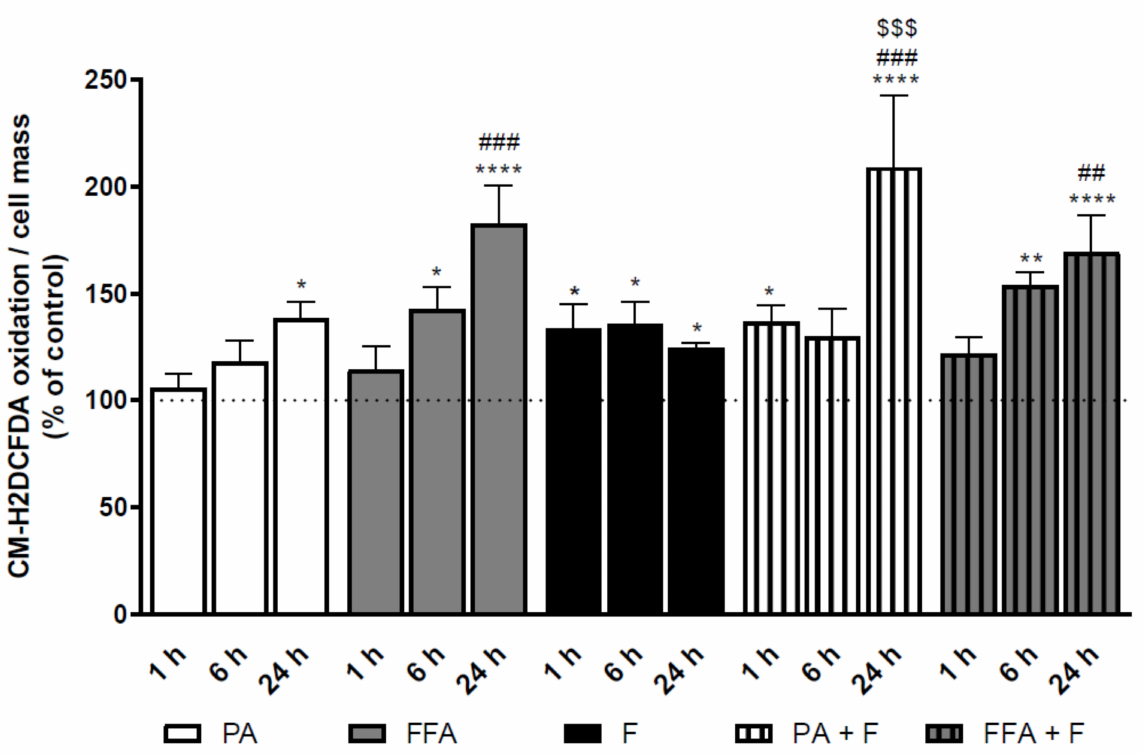
Figure 2. Time-dependent effect of supra-physiological concentrations of FA on the levels of CM-H 2 DCFDA-oxidizing ROS. Average cellular CM-H 2 DCFDA oxidation signal in cells treated with palmitic acid (PA, 0.5 mM) or a mix of free fatty acids (FFA, 0.25 mM) in the presence or absence of fructose (F, 10 mM) for 1, 6 and 24 h. Data are the mean ± SEM of four independent experiments, and the results normalized on the control condition (CTL = 100%, marked by a dotted line). Significance was accepted with * p < 0.05, ** p < 0.01, **** p < 0.0001 for comparisons between treatment vs. CTL (BSA 0.01 g/mL) and ## p < 0.01, ### p < 0.0005 for comparisons during time in the same group (24 and 6 h vs. 1 h). Significance for additional fructose effect as accepted with $$$ p <